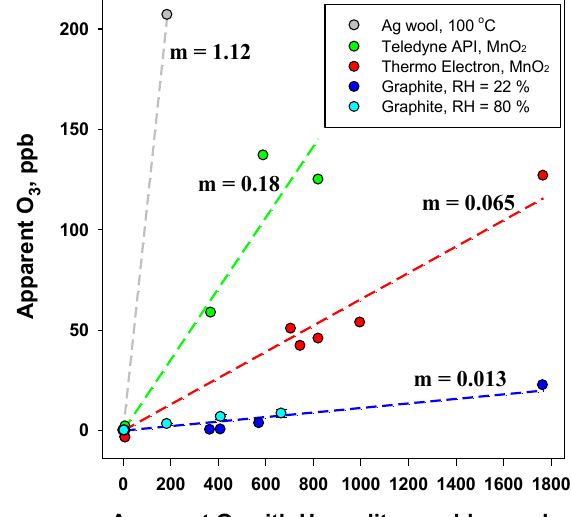
Figure 6. Apparent ozone measured in the Model 202 single-beam ozone analyzer using different ozone scrubbers, relative to the stan- dard Hopcalite scrubber, upon addition of mercury vapor to ozone- free air. Slopes are given by the m values. The graphite scrubbers were heated to 100 ◦ C for these